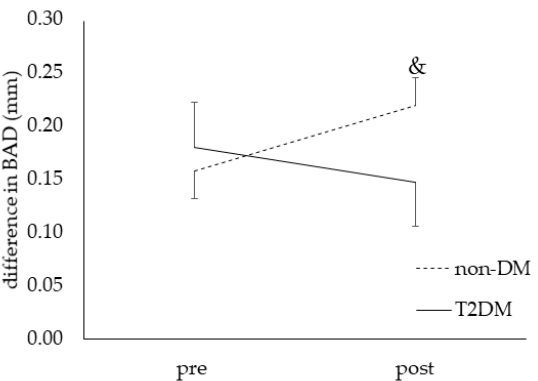
Figure 2. Difference in brachial artery diameter (BAD) in response to breakfast and capsules ingestion (cocoa flavanols and placebo combined) in both groups. Legend: Data are means ± SE. Main effects from mixed models when significant: time × group interaction for the difference in BAD (tendency, p = 0.07); post hoc analyses: no significant pairwise group differences, but a significant pairwise time difference in the non-diabetic group ( p = 0.03; &); difference in BAD = BAD post cuff deflation minus BAD pre cuff inflation.